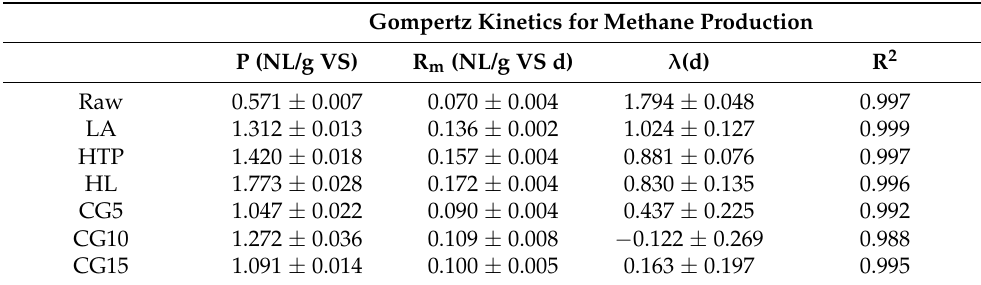
Table 6. Gompertz kinetics for methane production under different experimental conditions.